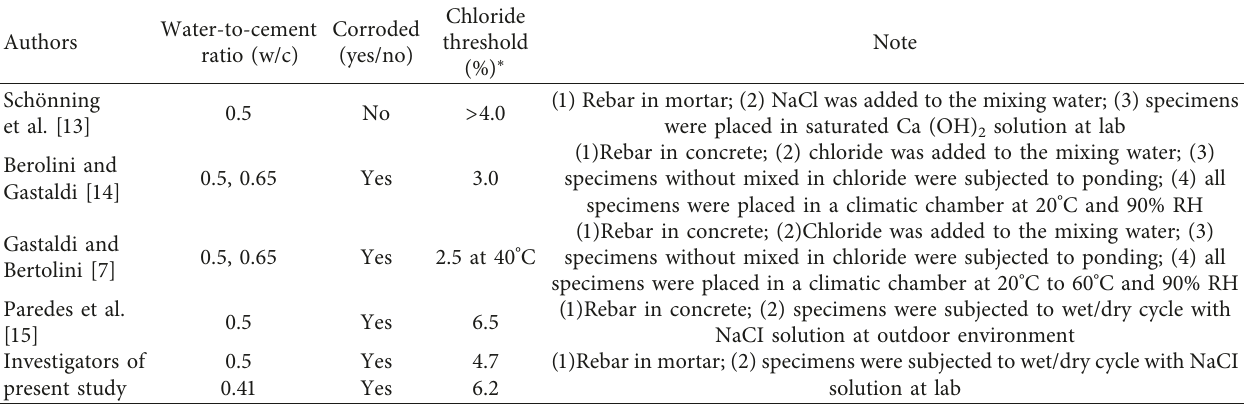
Table 5: Chloride threshold of the rebar UNS S32304 embedded in mortar and